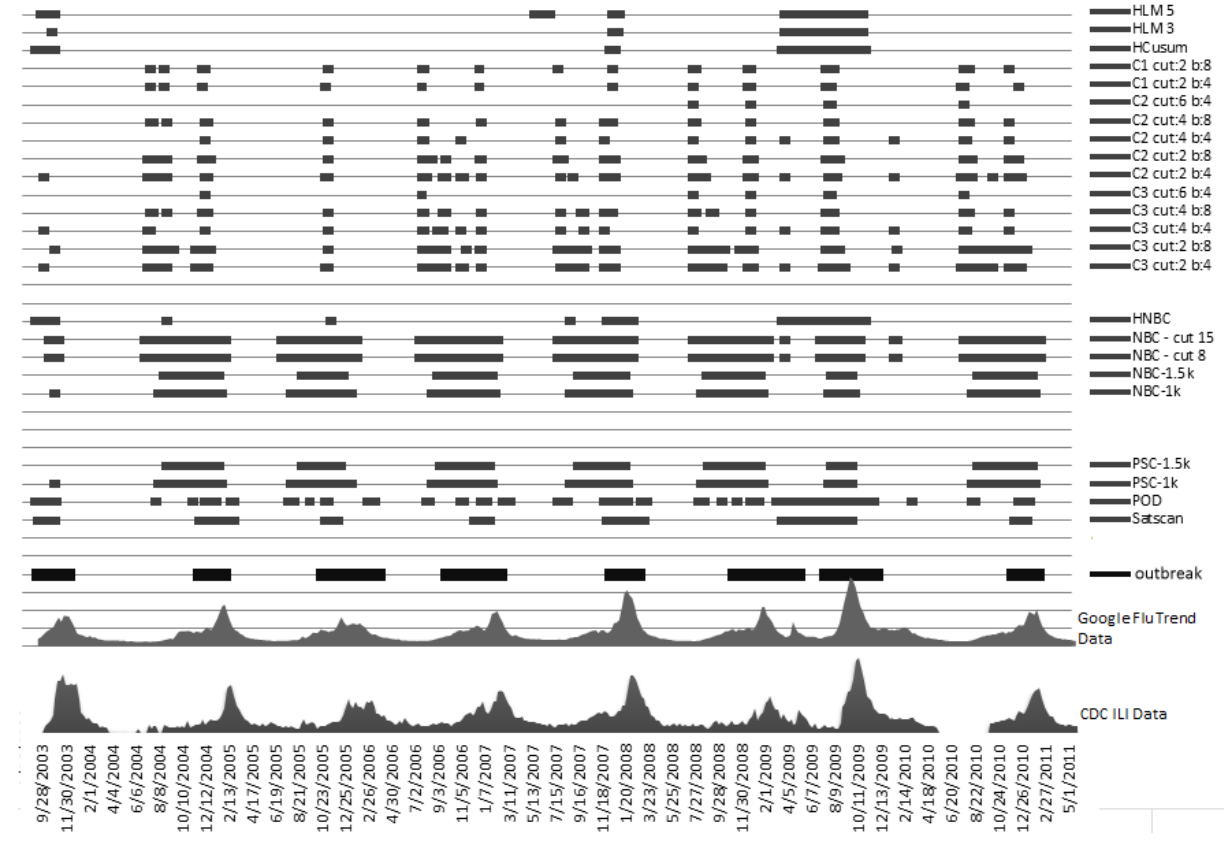
Figure 11. US Department of Health and Human Services region 6. The x-axis plots the Google Flu Trends and Centers for Disease Control and Prevention (CDC) data. The horizontal bars indicate where each method detected an epidemic. Cut indicates cut-off point (more is less sensitive) and b indicates baseline data (training window). The thick horizontal bar at the bottom shows the actual outbreak. HCusum = historical cumulative sum, HLM = historical limits method, HNBC = historical negative binomial cumulative sum, ILI = influenza-like illnesses, k = reference value for threshold, NBC = negative binomial cumulative sum, POD = Poisson outbreak detection, PSC = Poisson cumulative